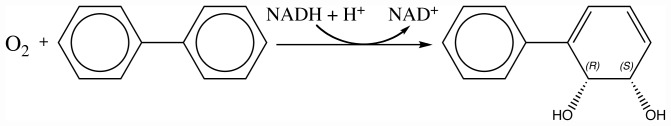
Scheme showing the initial reaction in the Bph pathway.